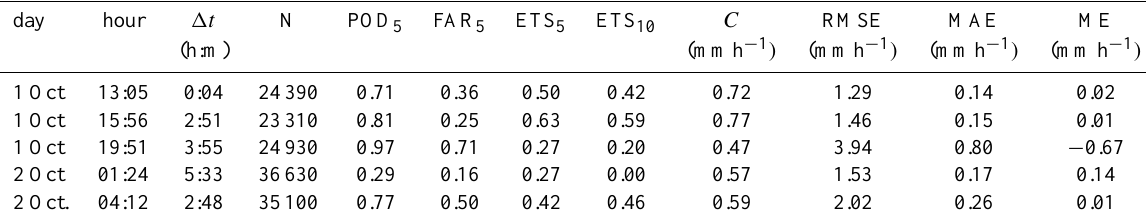
Fig. 5. Same as Fig. 4 but at a different time – 2 October 2009, 01:27UTC for 1 T B and 01:24UTC for RR. Table 2. Statistical comparison of PM-GCD-based and AMSU-based rain rates for the five rows of Fig. 8. Date and AMSU overpass time are reported in the first two columns. Column Dt refers to the time interval from previous AMSU overpass, while following column N refers to size of the sample, which is given by the number of MW-radiometer grid pixels considered in the observation. The following four columns show the Probability of Detection (POD), the False Alarm Rate (FAR) and the Equitable Threat Score (ETS) calculated using a 5mmh − 1 rain rate threshold and the ETS with a 10mmh − 1 threshold. The last four columns show the Correlation ( C ), Root Mean Squared Error (RMSE), the Mean Absolute Error (MAE) and the Mean Error